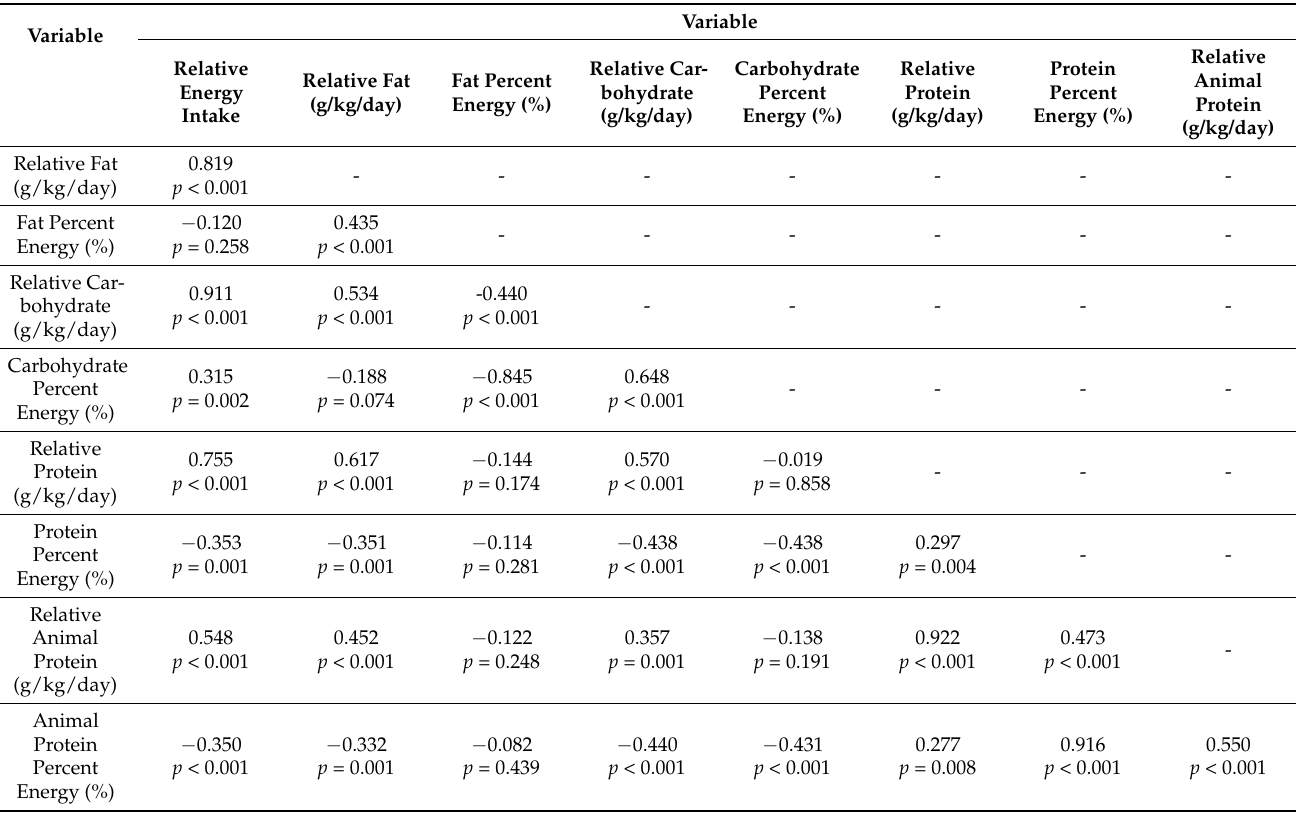
Table 7. Pearson Product–Moment Correlations of macronutrient intakes, including animal-based protein, and relative energy intake in 41 middle-aged men and 50 middle-aged